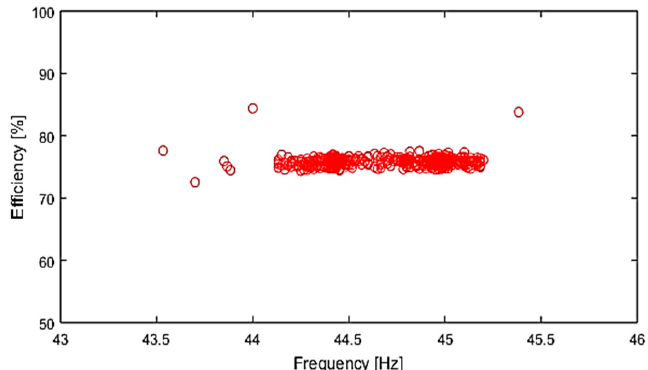
Figure 10. The characteristic F = f ( E Pe,n ) for the hydraulic regime with two pumps in operation.